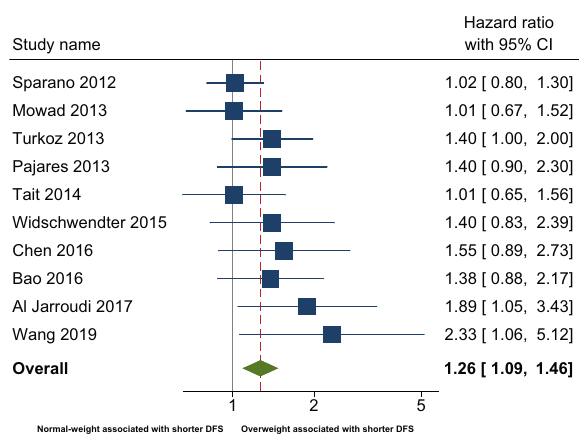
Fig. 2 Meta-analysis of observational studies comparing disease- free survival in overweight and normal-weight. * Disease-free survival was de fi ned as time from breast cancer diagnosis to fi rst breast cancer event or death.